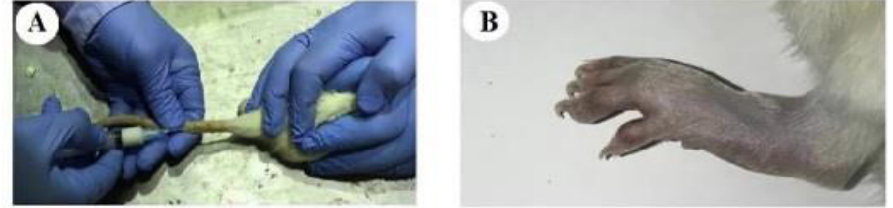
Figure 1. Induction of adjuvant-induced arthritis (AIA) and the progression of RA in the model rats. ( A ) Injection of the complete Freund’s adjuvants (CFAs) containing heat-killed M. tuberculosis emulsification reagent at 1.5 – 2 cm from the base of the tail. ( B ) the progression of arthritis (swelling, redness, and joint deformities) on the first day of consuming the diet.